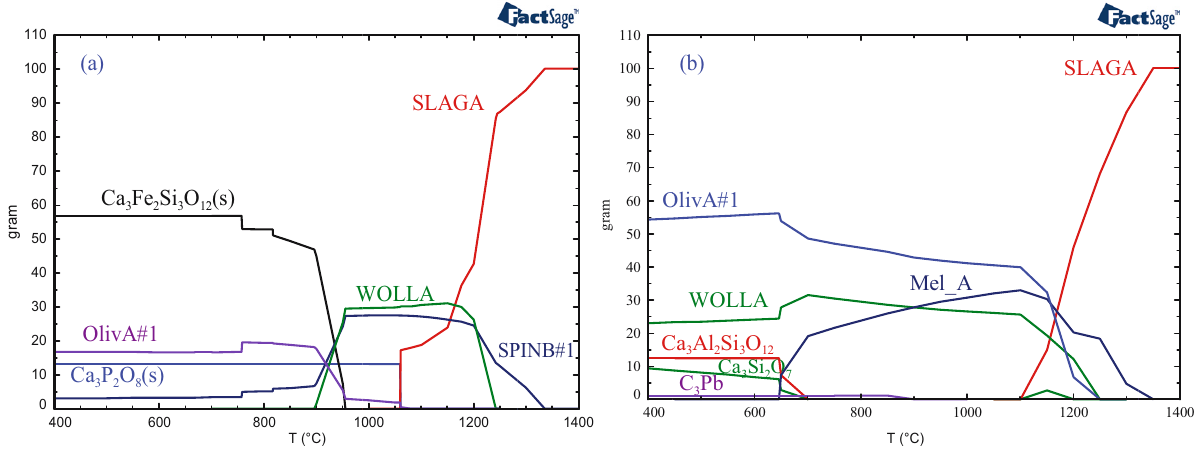
Figure 8: Main phases and precipitation behavior of slag A before and after the experiment: ( a ) R = 1.0 ( initial slag ) , ( b ) R = 1.0 ( fi nal slag )